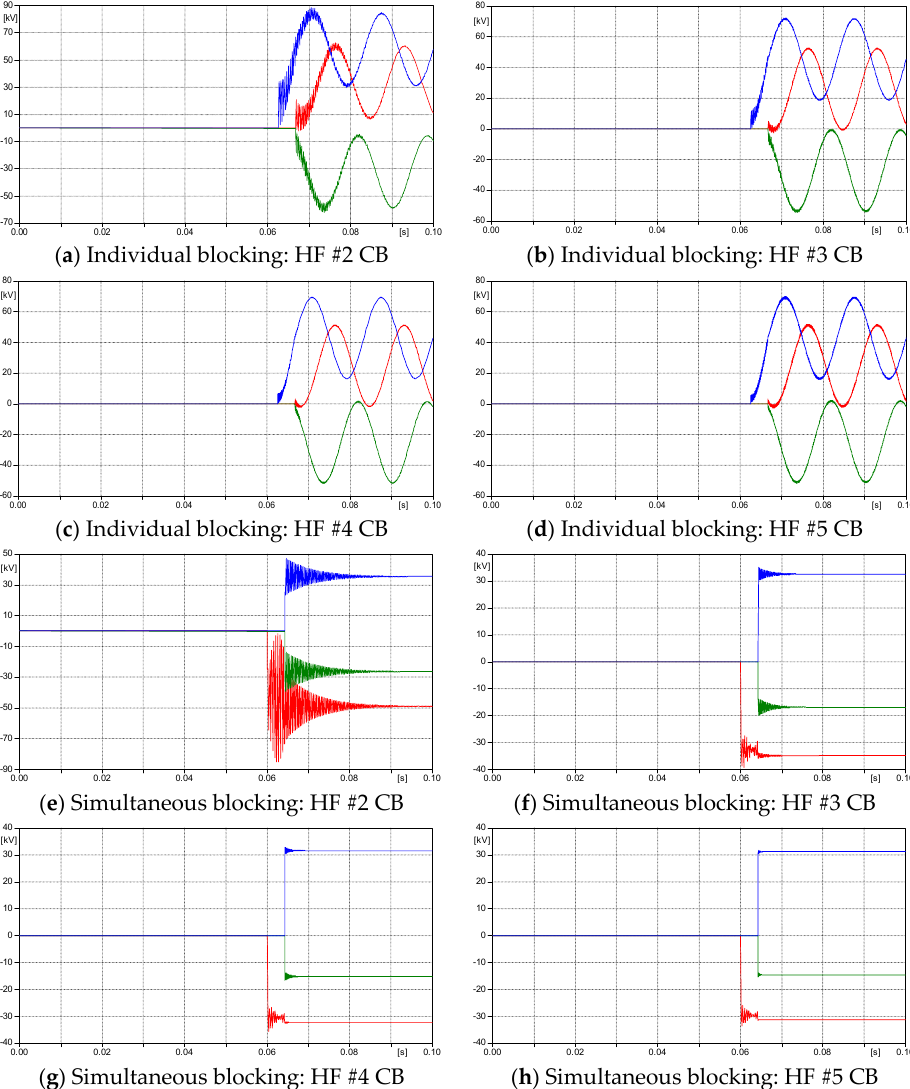
Figure 14. Simulation results of the transient recovery voltage for Case 2.